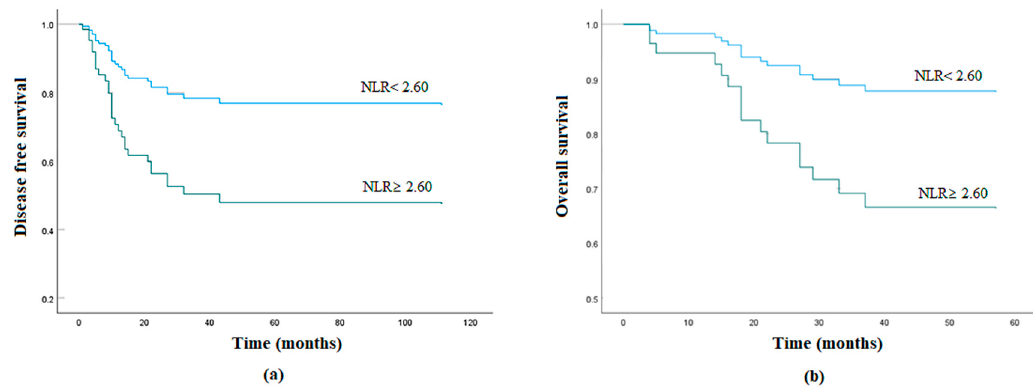
Figure 1. Survival curves of uterine sarcoma according to NLR: ( a ) Kaplan–Meier survival curves for disease-free survival (DFS) of patients with a high NLR and those with a low NLR. Patients with a high NLR had significantly shorter DFS than those with a low NLR (log-rank test, p = 0.006). ( b ) Kaplan–Meier survival curves for overall survival (OS) of patients with a high NLR and those with a low NLR. Patients with a high NLR had a significantly shorter OS than those with a low NLR (log-rank test, p = 0.045).